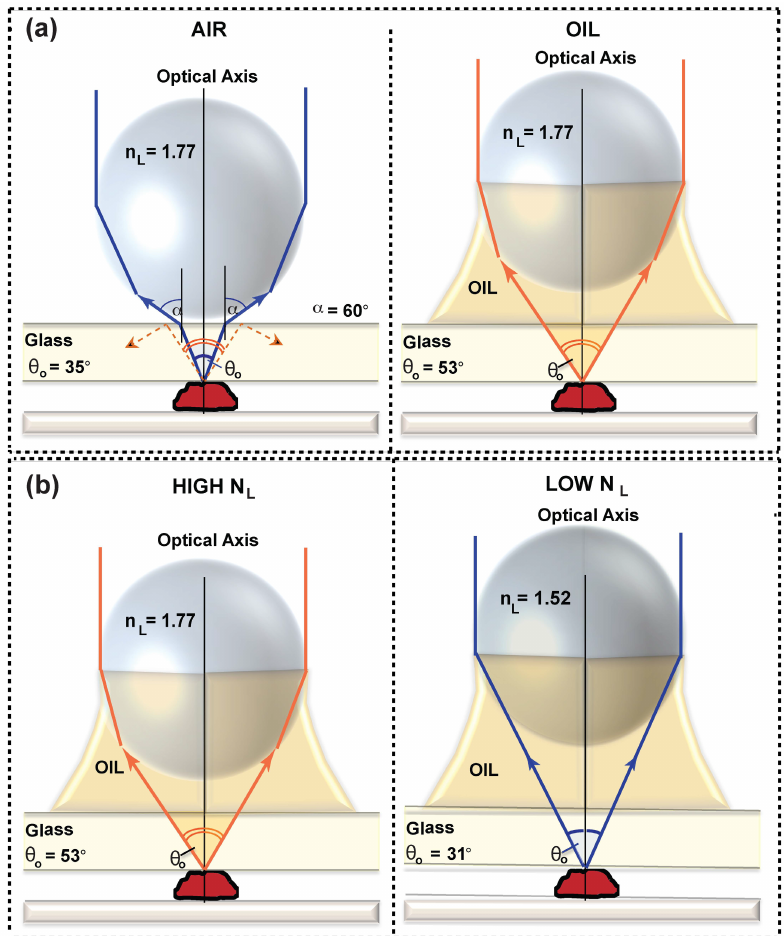
Figure 3. The effect of the refractive index of the immersion medium ( a ) and ball lens ( b ) on the ray collection angle θ Values for angle θ are theoretically estimated by thick-lens o o equations (see supplementary materials and Figure